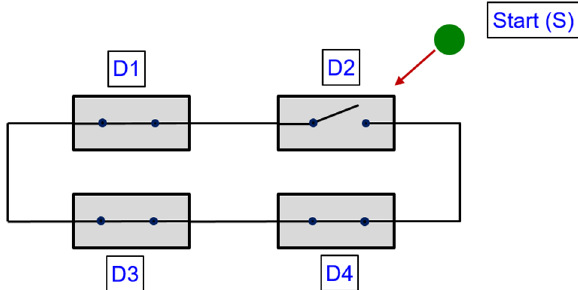
FIG. 6. Model reflecting a loop architecture with four compo- nents, with one detector opening the